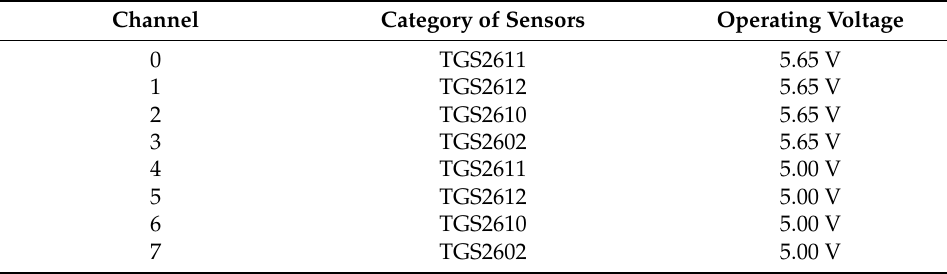
Table 1. Sensor types and operating voltages. The different concentration levels of the four measured gases are shown in Table 2. Table 2. Different concentration levels of measured gases